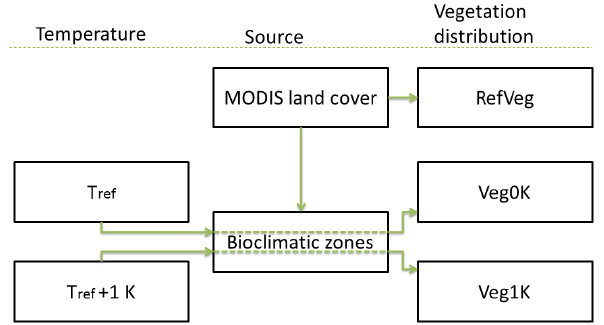
Figure 2. Illustration of the procedure applied to derive the vegeta- tion distributions used in each simulation. T ref is the mean summer (JJA) temperature distribution in the area as averaged across 2001– 2010 (from Rydsaa et al., 2015). T ref + 1K is the same tempera- ture distribution, with a 1K increase. Each of the three distributions has been simulated for two climatically contrasting years (cold and warm), yielding in total six